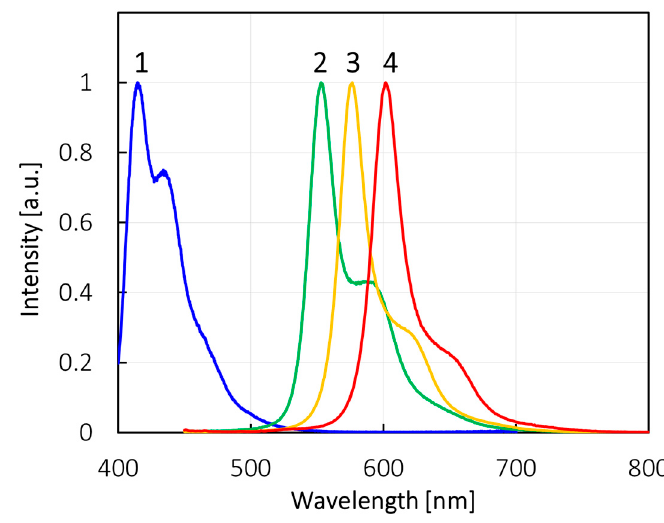
Figure 5. Fluorescence spectra of 1 – 4 in dichloromethane. The excitation wavelength was fixed at 365 nm in all scans.